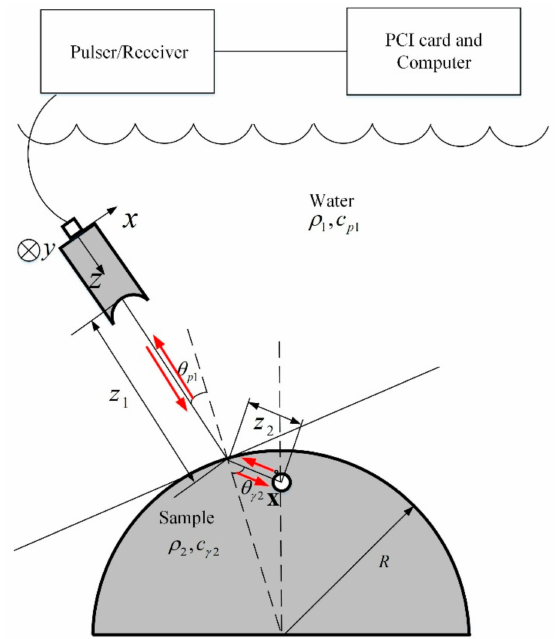
Figure 1. Schematic diagram of the experimental test